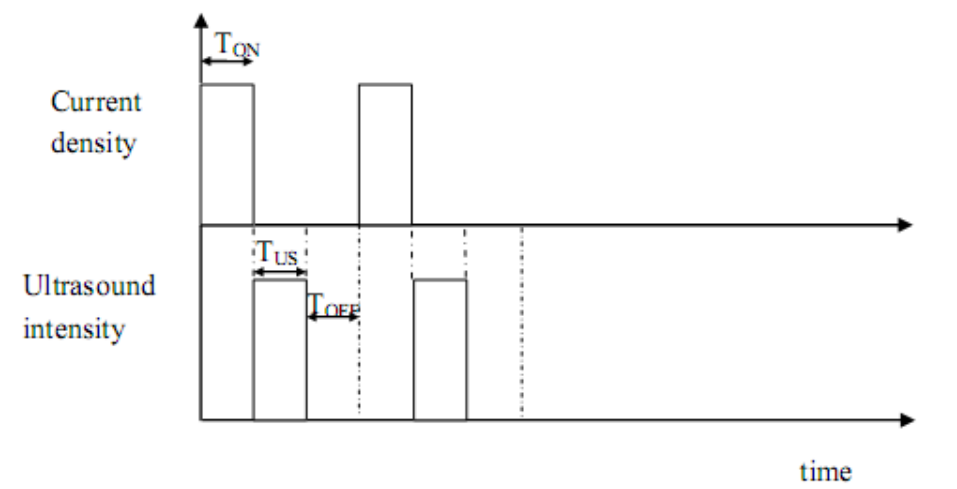
Figure 2. Distribution of the ultrasound and current pulses with the time (T ultrasound pulse time and T time, T US